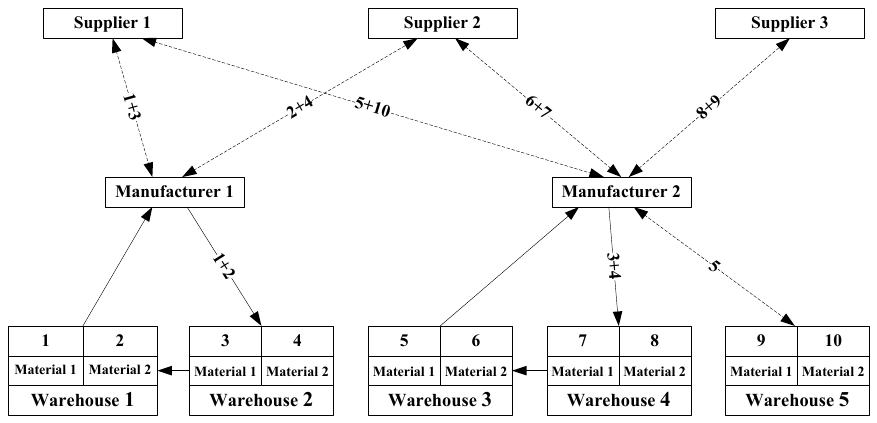
Figure 6. Instance for decoding the bat